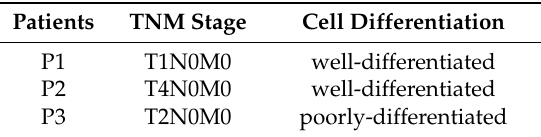
Table A1. Patient